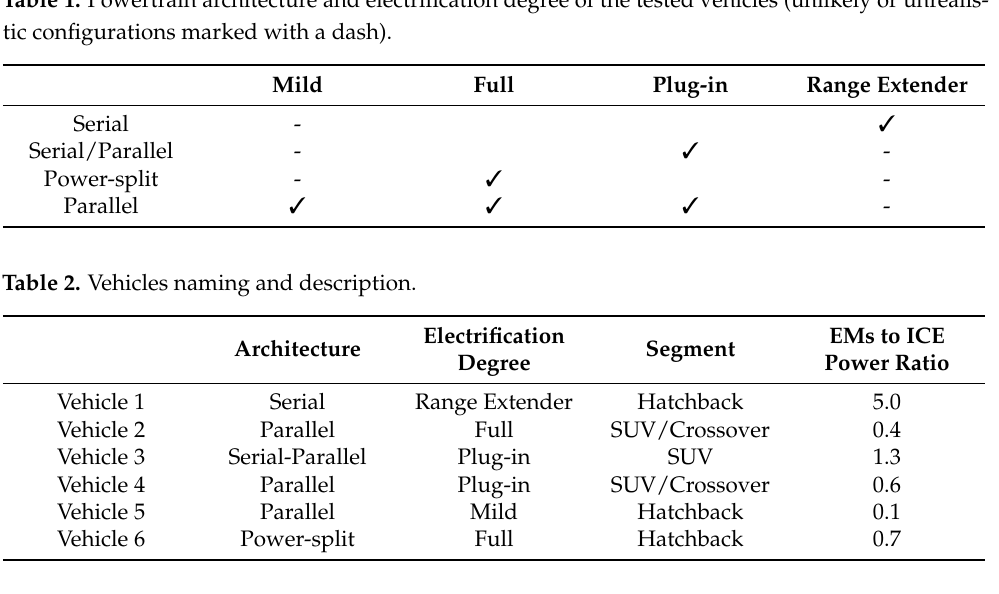
Table 3. Vehicles electric machines